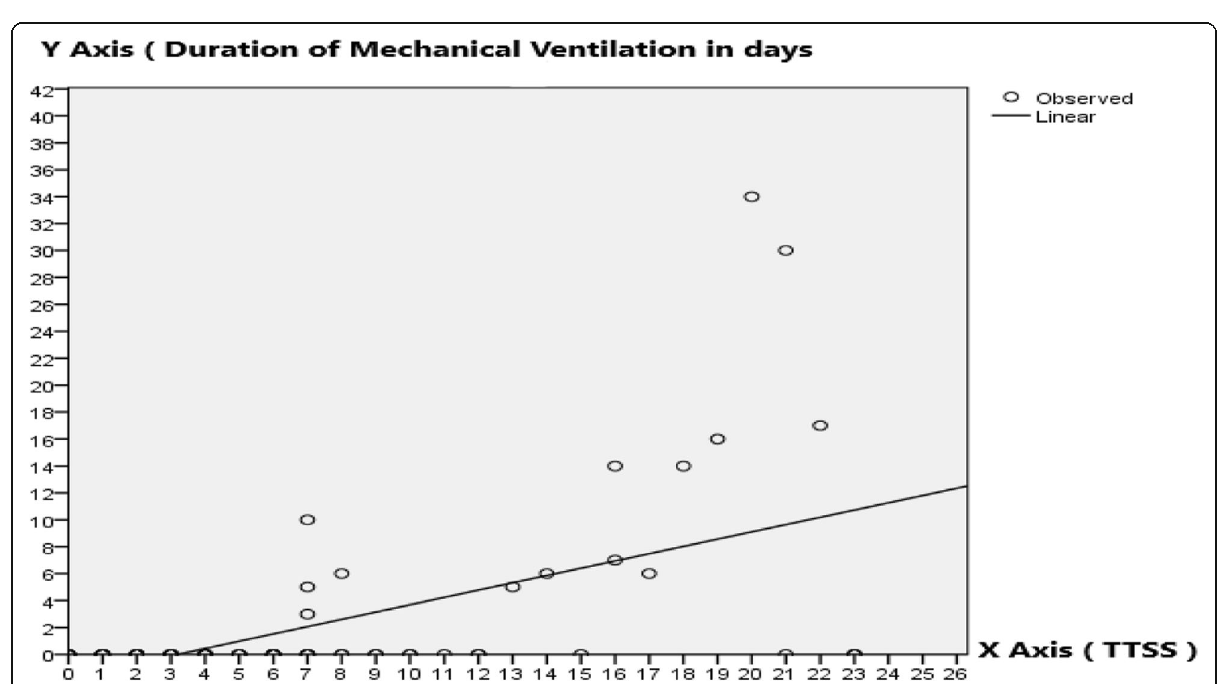
Fig. 1 Regression curve showing the effect of increasing TTSS (X-axis) on the duration of mechanical ventilation (Y-axis). ( p <